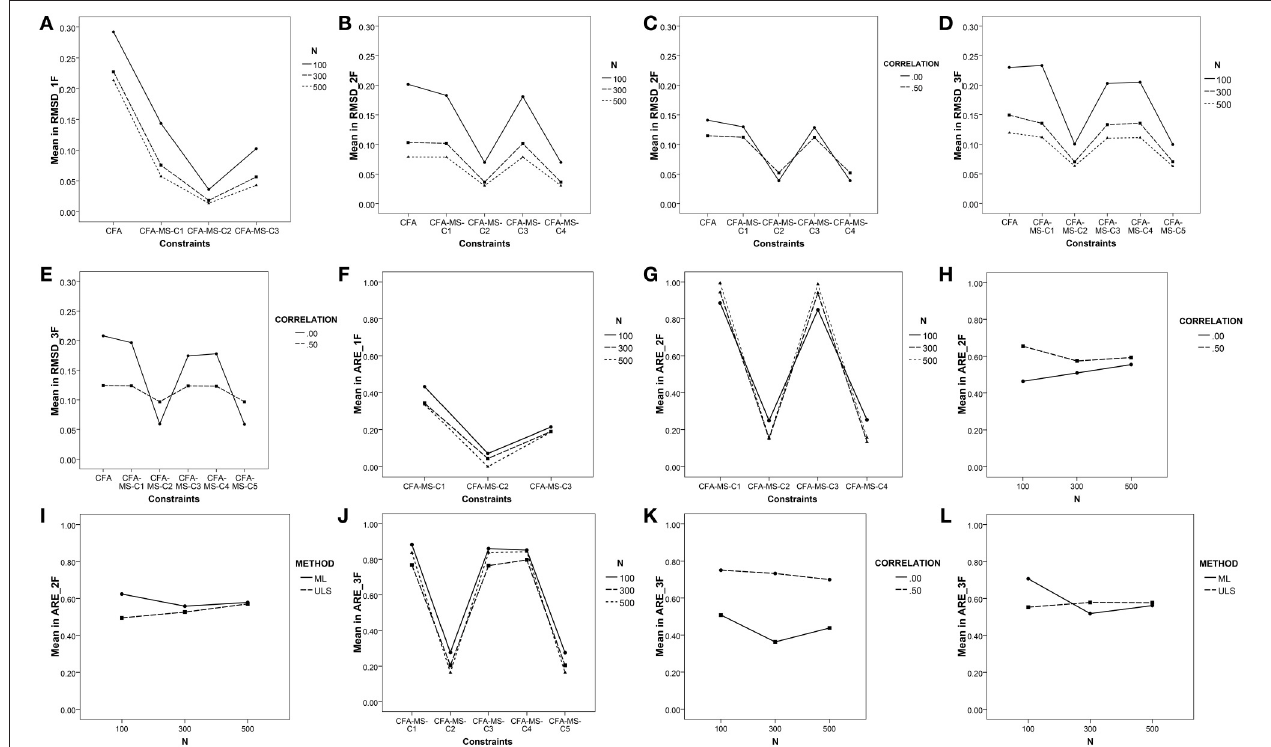
FIGURE 1 | Graphical representation of the strongest double interaction effects found on the recovery of weak factor loadings and the ARE measure. (A) NxC interaction and RMSD (1F); (B) NxC interaction and RMSD (2F); (C) CxCO interaction and RMSD (2F); (D) NxC interaction and RMSD (3F); (E) CxCO interaction and RMSD (3F); (F) NxC interaction and ARE (1F); (G) NxC interaction and ARE (2F); (H) NxCO interaction and ARE (2F); (I) MxN interaction and ARE (2F); (J) NxC interaction and ARE (3F); (K) NxCO interaction and ARE (3F); (L) MxN interaction and ARE (3F).